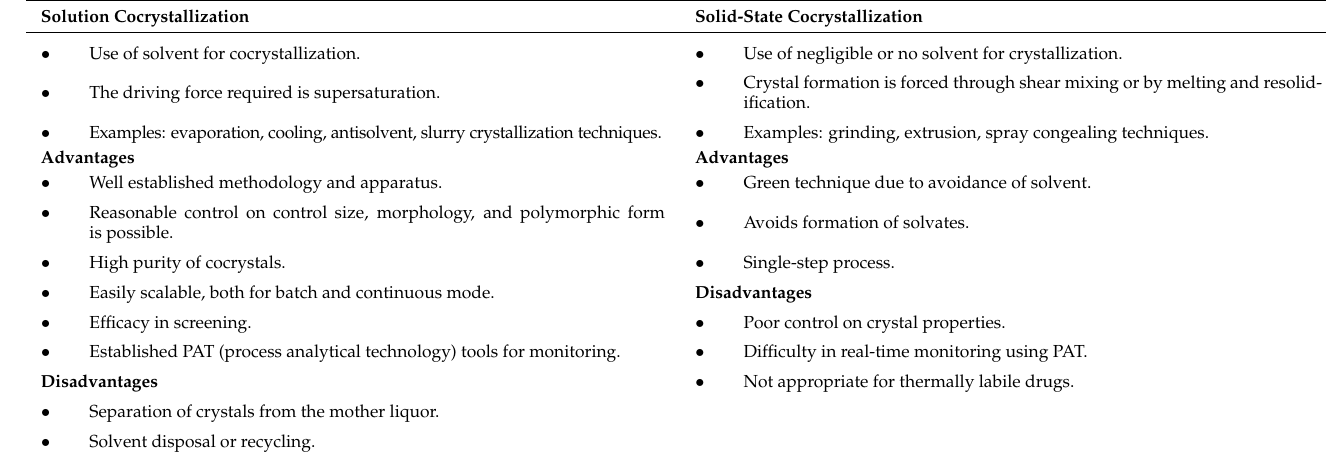
Table 1. Advantages and disadvantages of the solution and solid-state